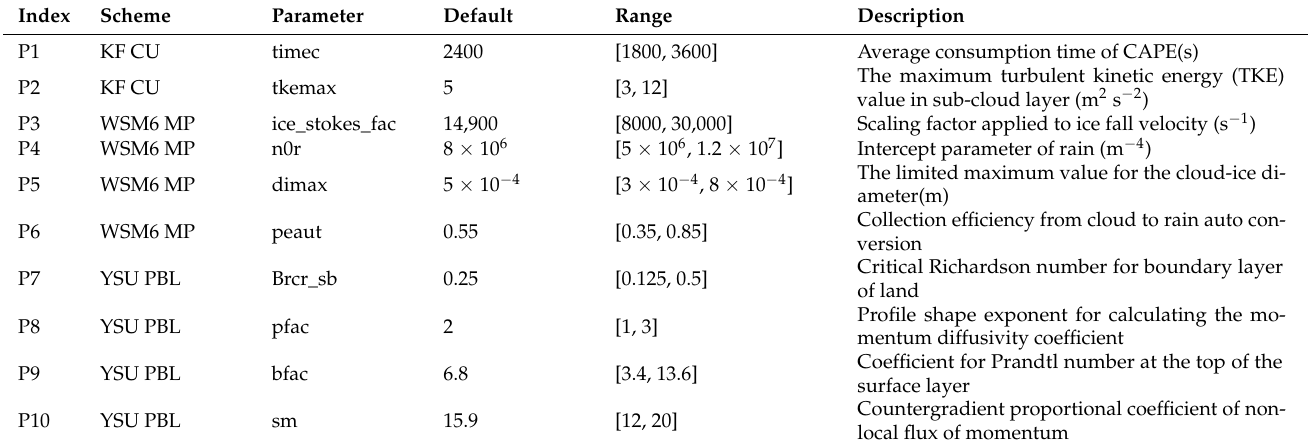
Table 4. Uncertain parameters and their variability ranges in three physical